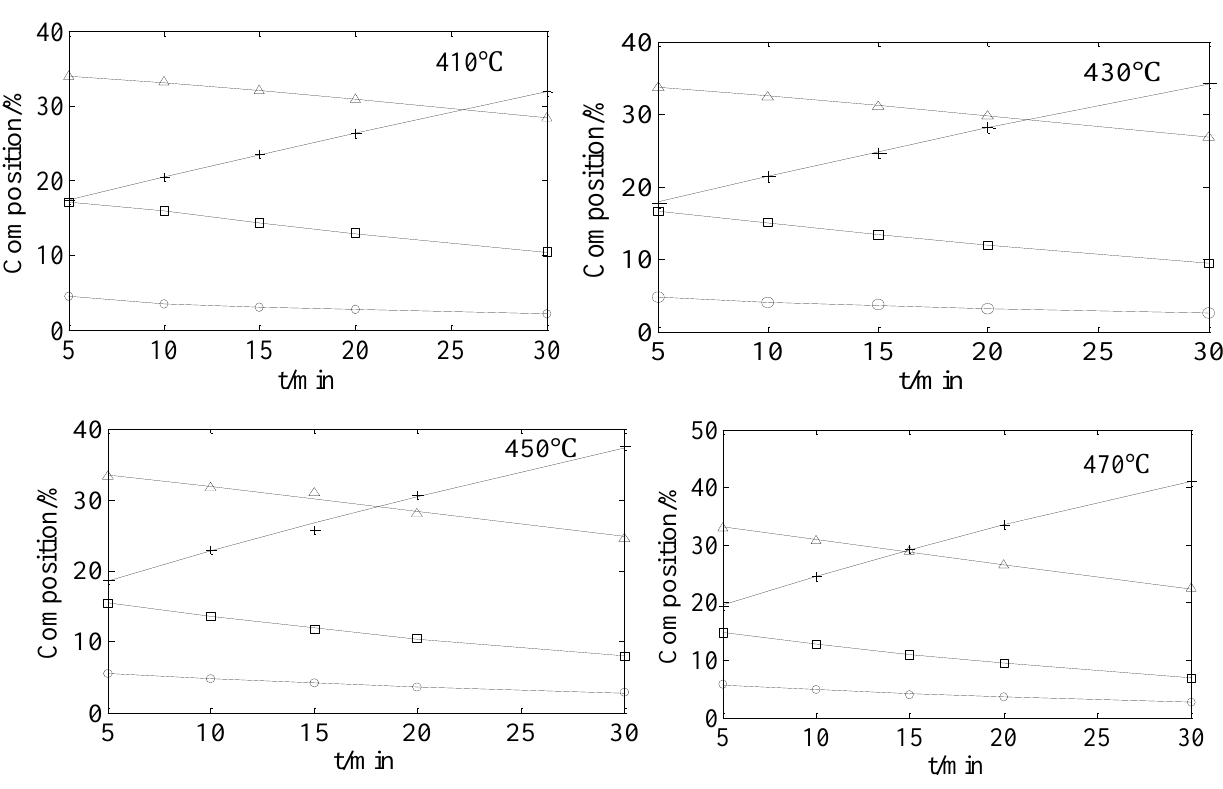
Figure 4. Comparison of kinetic model(lines) with experimental data (dots) of Shenhua CHLR hydrogenation at various